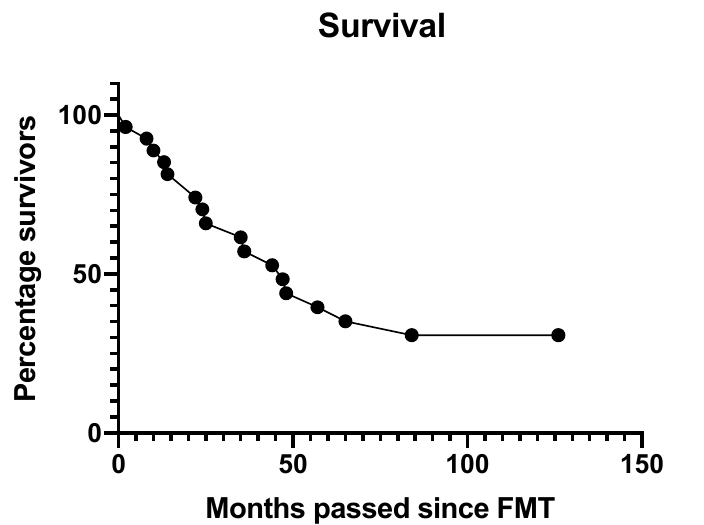
Figure 2. Survival following FMT of patients ( n = 34) from the randomized controlled trial [7].